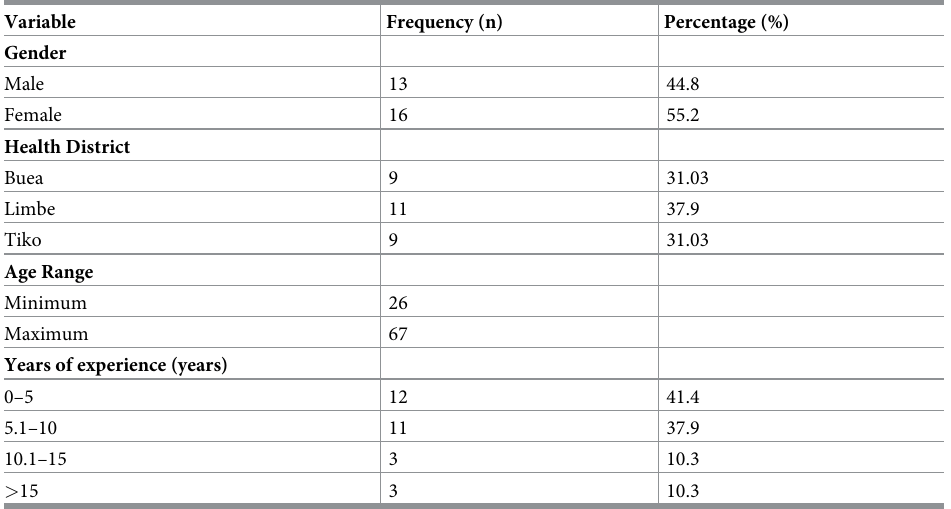
Table 2. Socio-demographic characteristics of participants of FGDs (n =